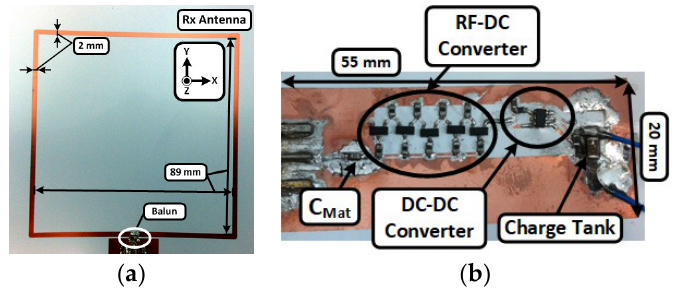
Figure 6. Fabricated RF energy harvesting system prototype utilizing the hybrid printed electronic